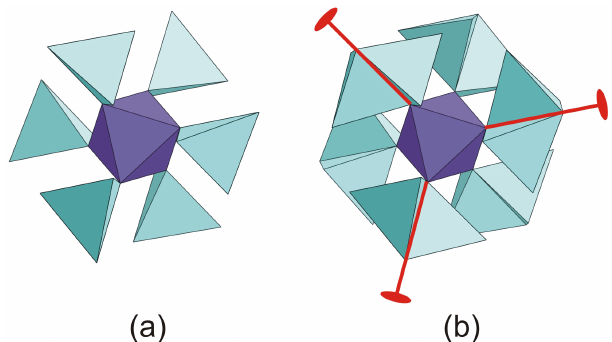
Figure 5. In (a) a possible ordering scheme is sketched for the ori- entations of the MoO 4 tetrahedra around to a FeO 6 octahedron, which is compatible with a threefold axis. Such ordering cannot oc- cur in the cubic, tetragonal, or orthorhombic unit cells which index the superstructure reflections, as reported in Table 2. The effect of twofold axes is shown in (b)